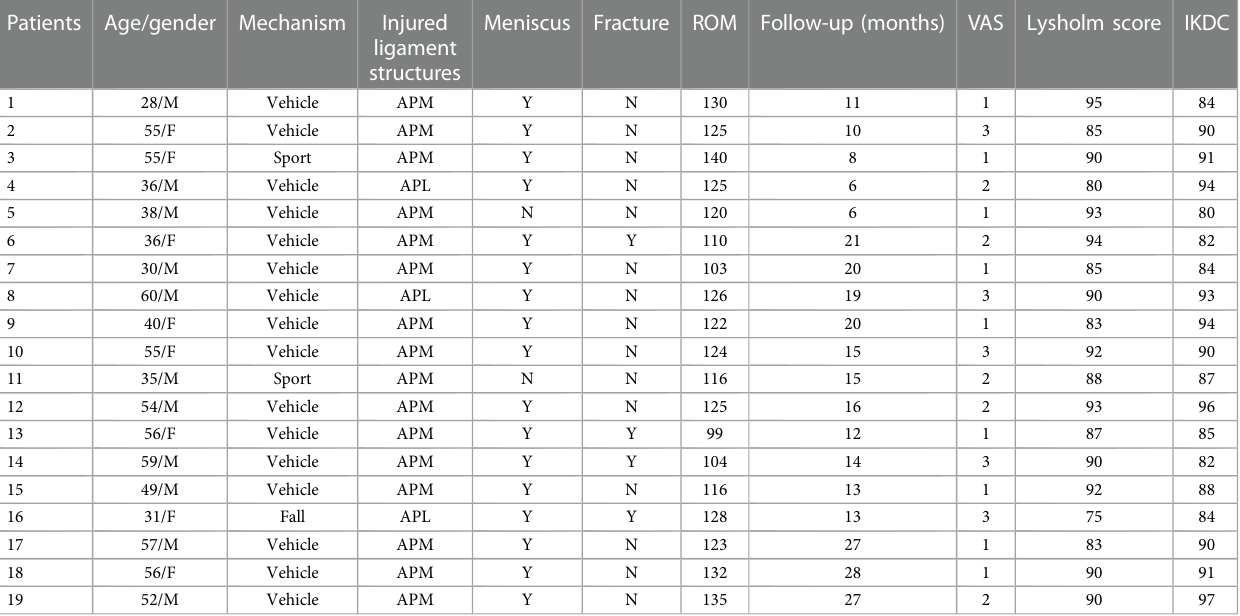
VAS, visual analog scale; IKDC, International Knee Documentation Committee Subjective Knee Form; ACL, anterior cruciate ligament; PCL, posterior cruciate ligament; MCL, medial collateral ligament; LCL, medial or lateral collateral ligament; Y, Yes; N, No; ROM, range of